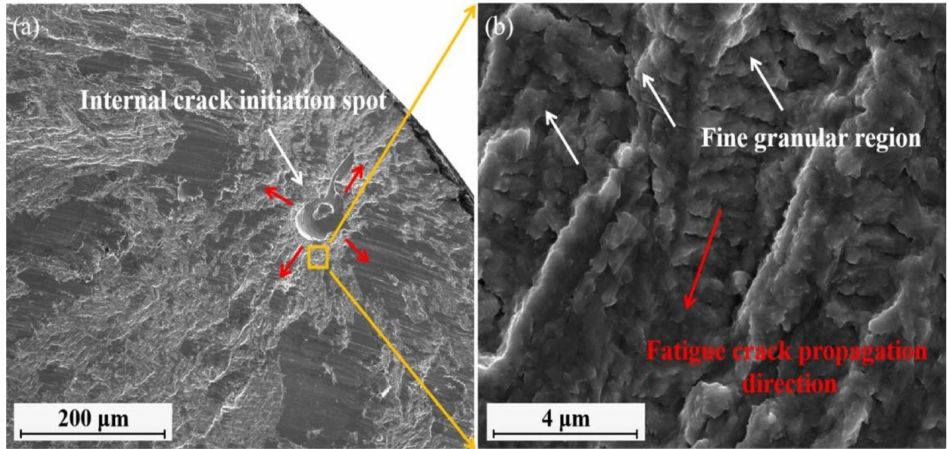
Figure 17. ( a ) Fatigue crack initiation from AM internal LOF defects; ( b ) fine granular regions near the crack initiation spot. Reprinted with permission from ref. [67]. 2021, Elsevier.